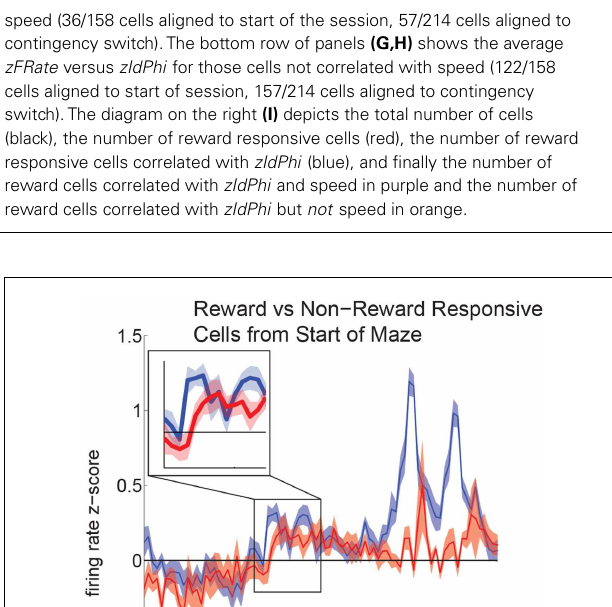
FIGURE 10 | Increased activity of reward cells at the choice point. Reward responsive cells showed significantly higher firing rates than non-reward responsive cells atT4 as well as at F1,F2 (ANOVA F = 5.3, P = 0.03; ANOVA F = 23, P < 0.01).We compared the normalized activity of reward responsive cells at salient maze locations by linearizing the tracking data from each session and assigning a set number of points between landmarks (Schmitzer-Torbert and Redish, 2004; van der Meer and Redish, 2009). A two-way ANOVA with lap (laps 1–10) and location on the maze (T1 to halfway to F1) as factors demonstrated a significant variation in firing rate across the navigation sequence ( F = 5.6, P < 0.01). ATukey post hoc comparison indicated that the activity atT4 was higher compared to other portions of the navigation sequence (T4: Mean = 0.44, Std = 0.07; Avg T1–T3: Mean =− 0.08, Std =